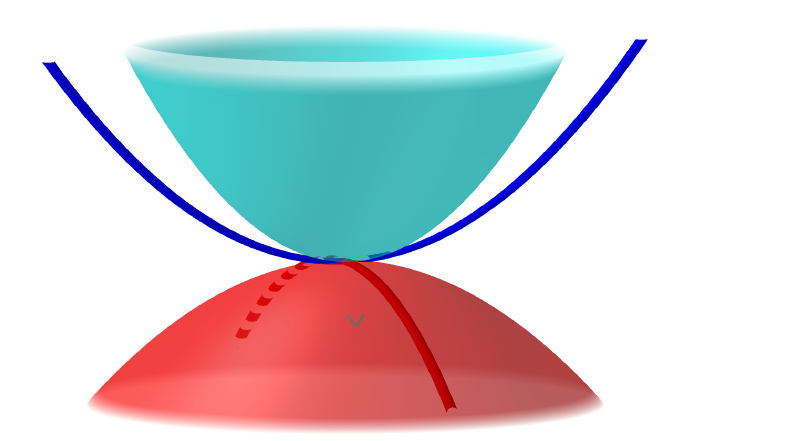
Figure 1. Illustration of two elements in an observer manifold. Two observers record events and make measurements in two different four-dimensional manifolds; represented schematically here are red and blue surfaces. They meet here at a space-time point represented by the point common to the two surfaces. The observers have space-time trajectories that are represented by traces on the event manifold (the blue and red curves). The observer manifold consists of all four-dimensional manifolds corresponding to all the states of all possible particles that are accessible to